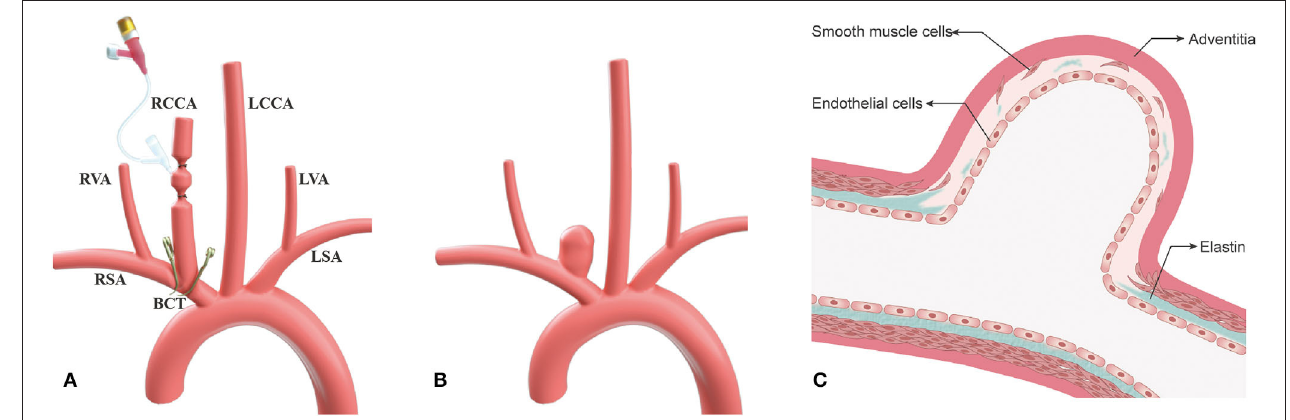
FIGURE 1 | The improved surgical technique, two temporary aneurysm clips technique, for aneurysm model in rabbits. (A) Schematic picture depicting an improved technique for increasing neck width of the aneurysm at the right common carotid artery (RCCA); (B) Illustration depicting wide-necked aneurysm at the RCCA after 3-week follow-up; and (C) Schematic illustration displaying sufficient elastin digestion at the aneurysm neck and dome. RCCA, right common carotid artery; LCCA, left common carotid artery; RSA, right subclavian artery; LSA, light subclavian artery; RVA, right vertebral artery; LVA, left vertebral artery; BCT, brachiocephalic